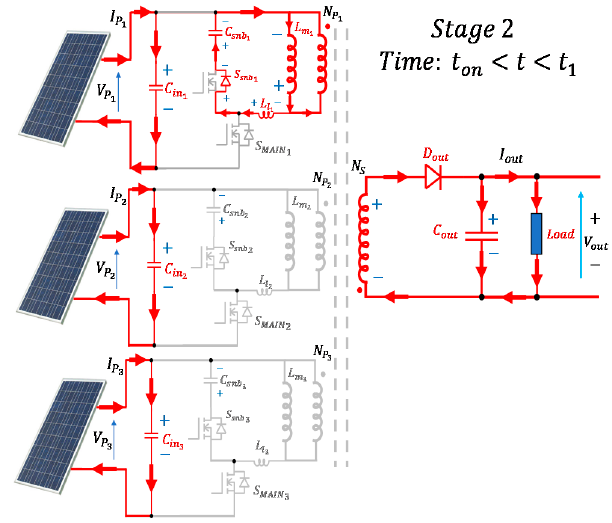
Figure 3. Stage 2, time: 𝑡 (cid:3042)(cid:3041) < 𝑡 < 𝑡 (cid:2869) .